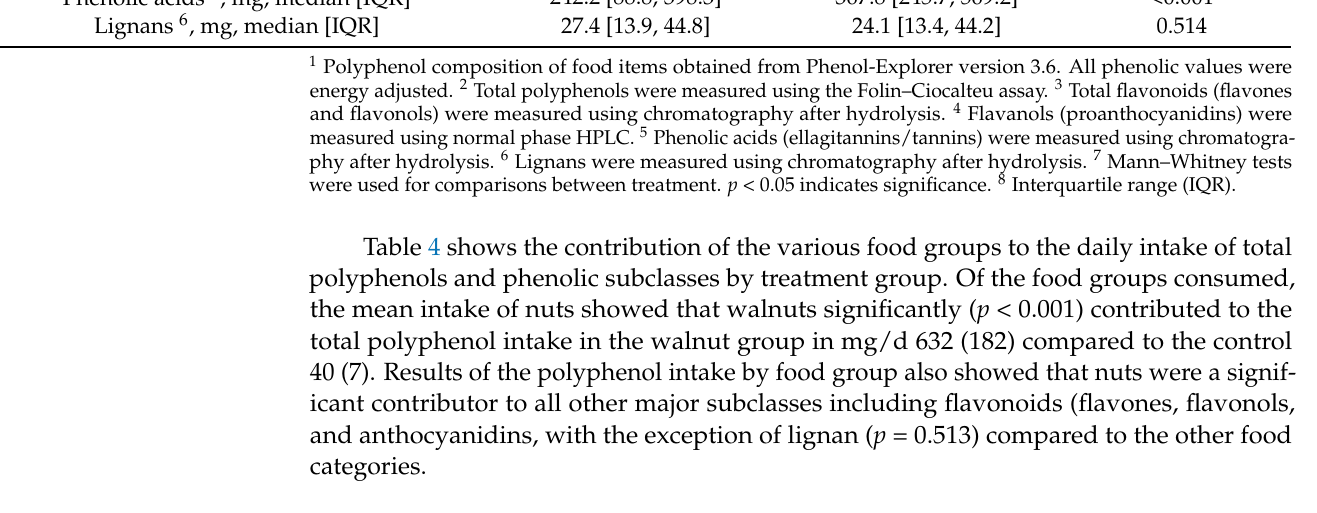
Table 4. Contribution of food groups by treatment group to the mean daily intake in mg/d of the total polyphenols and polyphenol